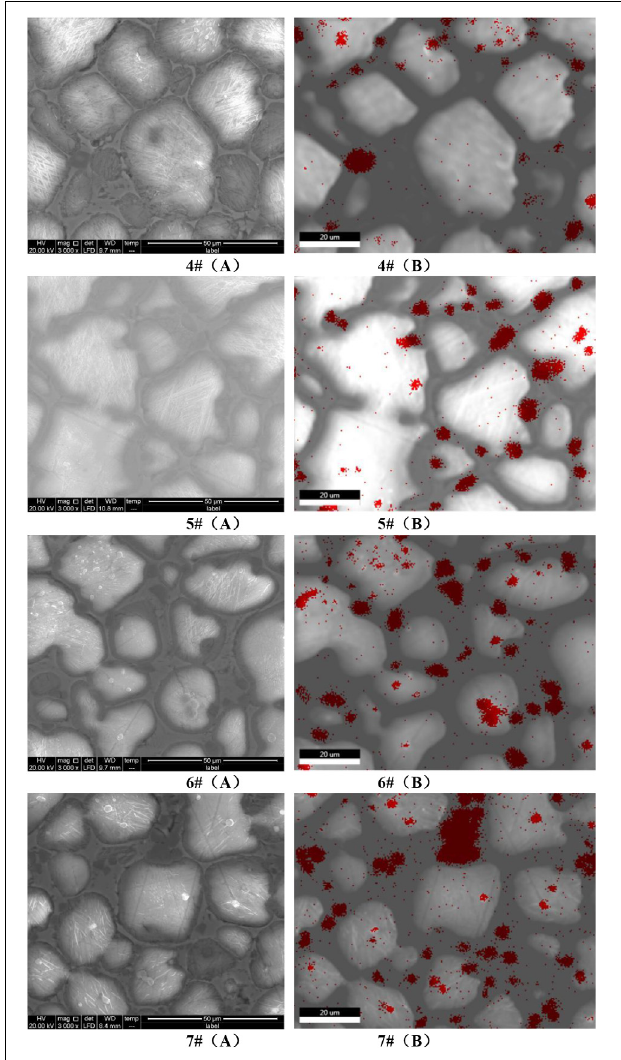
FIGURE 1 | Comparison diagrams of point scanning and map scanning of cement clinker with different MgO contents (A) and (B) of each number represent the point scanning diagram and the Mg element distribution diagram, respectively; the red part in the diagrams represent the distribution of Mg